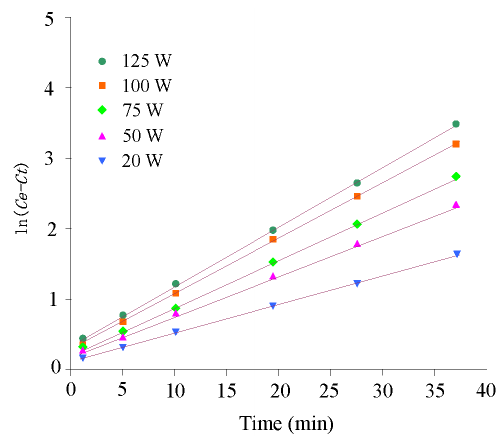
Figure 4. The relationship of ln ( C e − C t ) against extraction time ( t ) under different ultrasonic powers. Table 1. Parameters of Kinetic model of glycyrrhizic acid from Glycyrrhizauralensis with different ultrasonic powers .